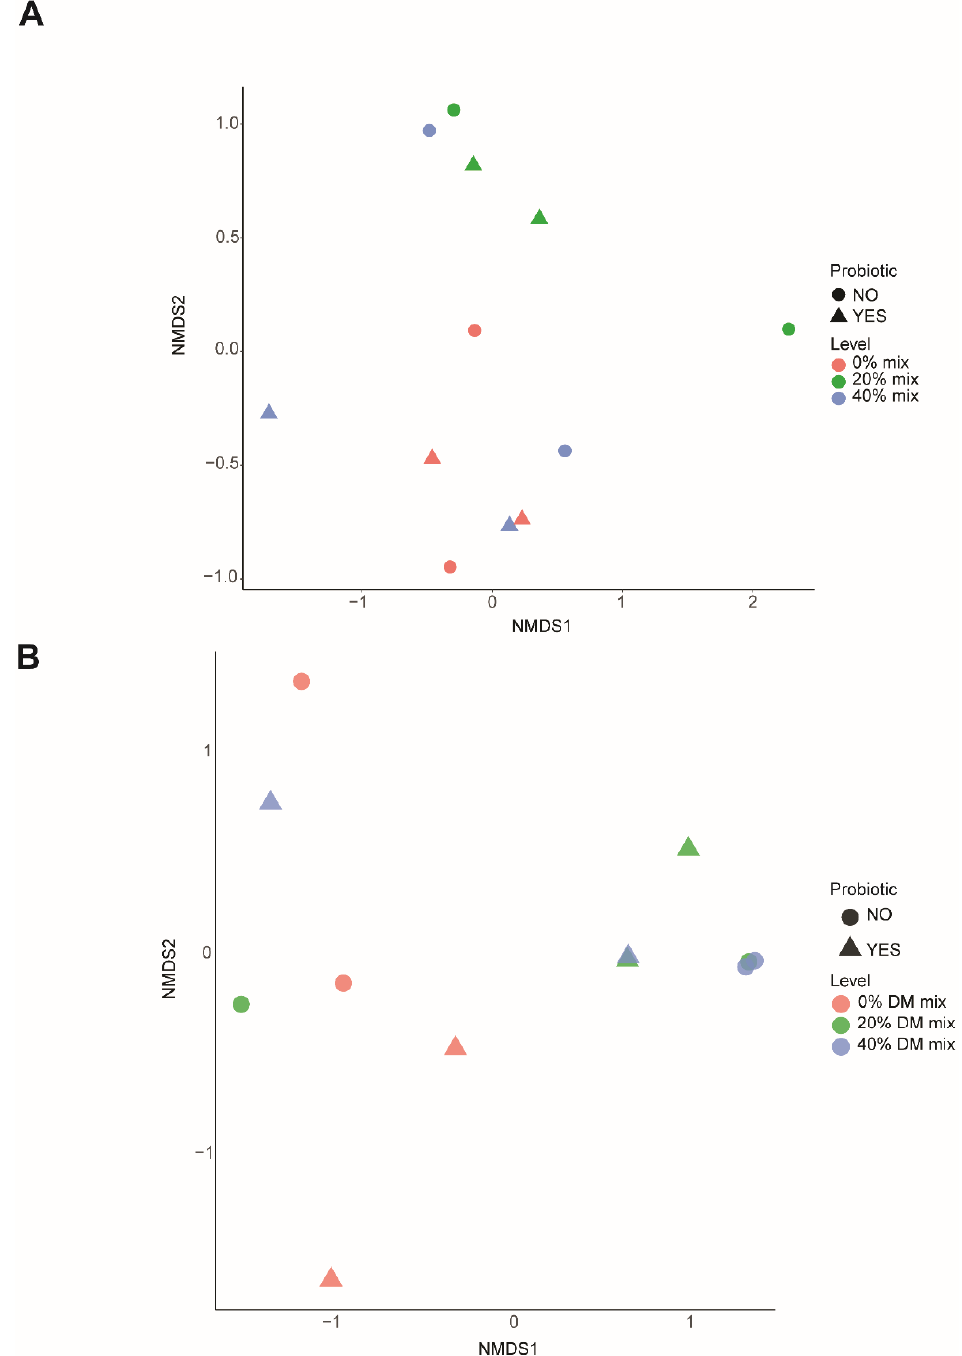
Figure 4. Non-metric multidimensional scaling analysis (NMDS) based on the Bray–Curtis dissimilari- ties for the fungal microbiota of sorghum ensiled with a vegetable mixture at 0, 20 or 40% DM ( A ) after ensiling for 101 d, as well as after ( B ) 14 d aerobic exposure, with or without a probiotic inoculant. Thirty-one fungal taxa were identified in the microbiota of the silages opened on day 101. Of these taxa, the interaction of level × probiotic reduced ( p = 0.01; Table S5) the rela- tive abundance of Cladosporium exasperatum from 0.50 ± 0.05% to an undetectable level